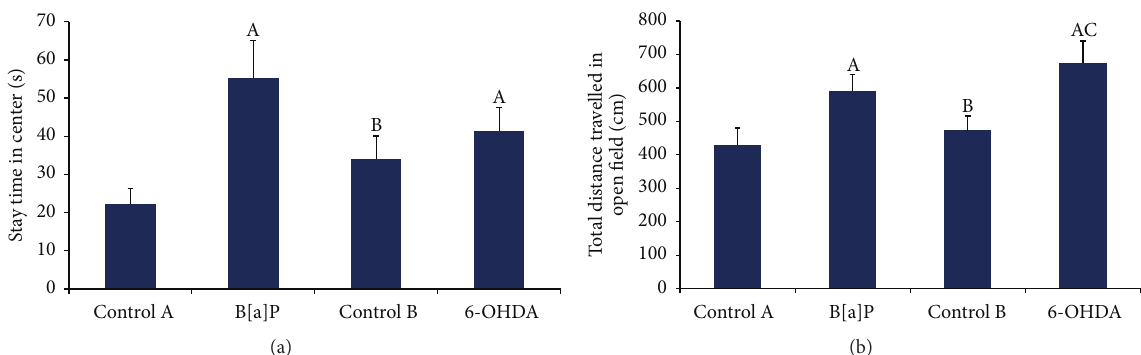
Figure 2: Open field test. Graphs showing alterations in time spent in central zone and total distance travelled in open field arena ((a) and (b)). Values are expressed as mean ± SEM ( 𝑛 = 12 /group). “A” denotes 𝑝 < 0.05 when compared to control A group, “B” denotes 𝑝 < 0.05 when compared to B[a]P group, and “C” denotes 𝑝 < 0.05 when compared to control B group.